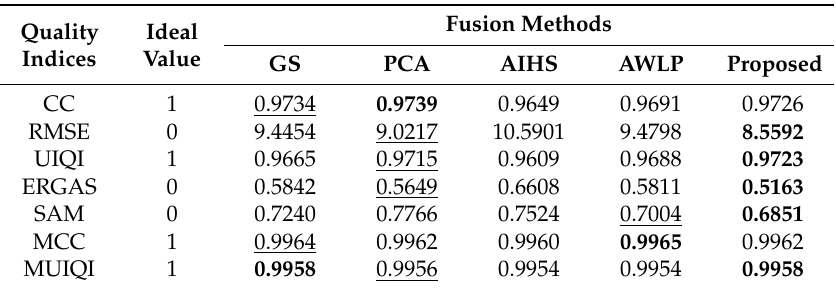
Figure 6. Horizontal profiles of the column means for the QuickBird fusion results. ( a ) band 1; ( b ) band 2; ( c ) band 3; ( d ) band 4. Table 3. Quantitative evaluation results of the QuickBird experiment (the best result is marked in bold, and the second best result is underlined).